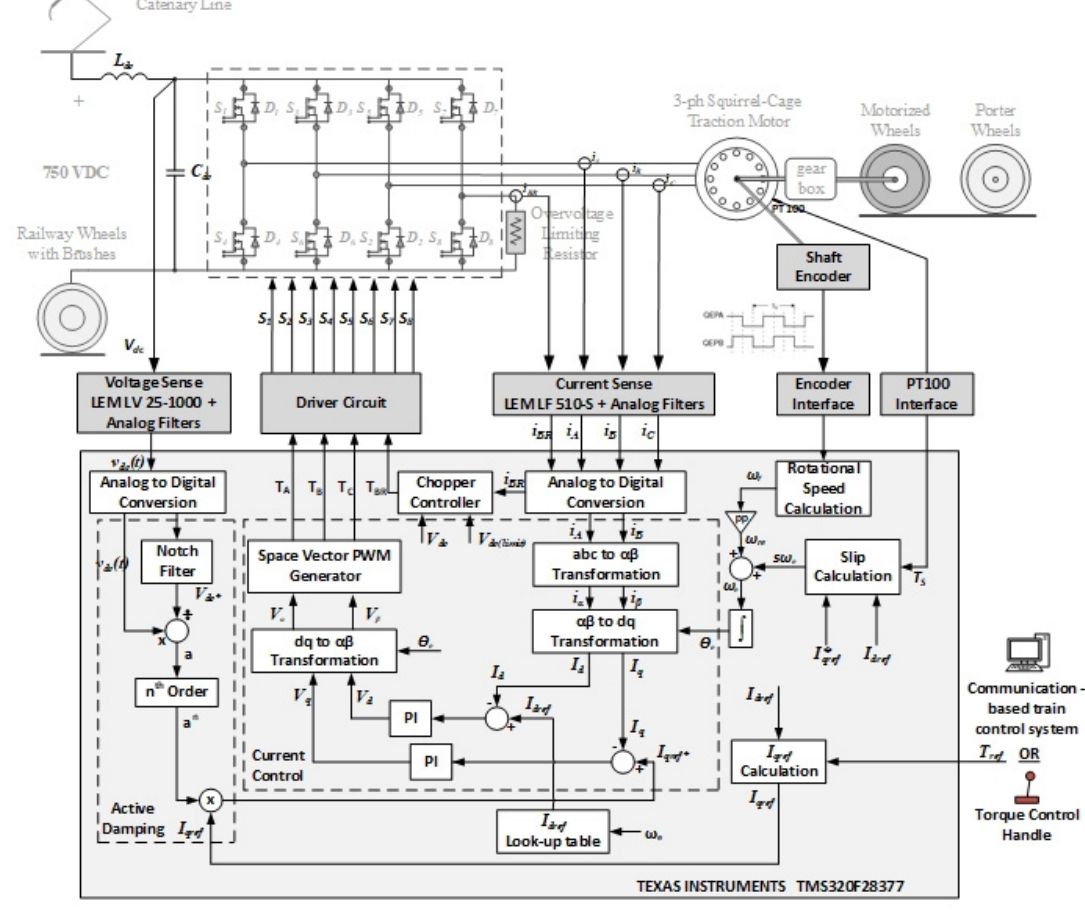
Figure 7. Block diagram of the digital control system with space vector PWM, active damping, and field-oriented control.